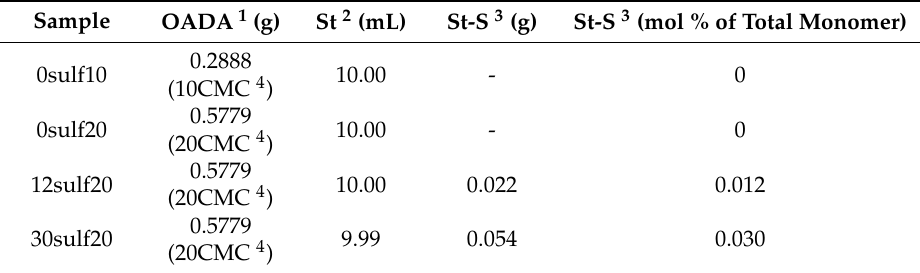
Table 1. Formulations for nanoparticles polymerization